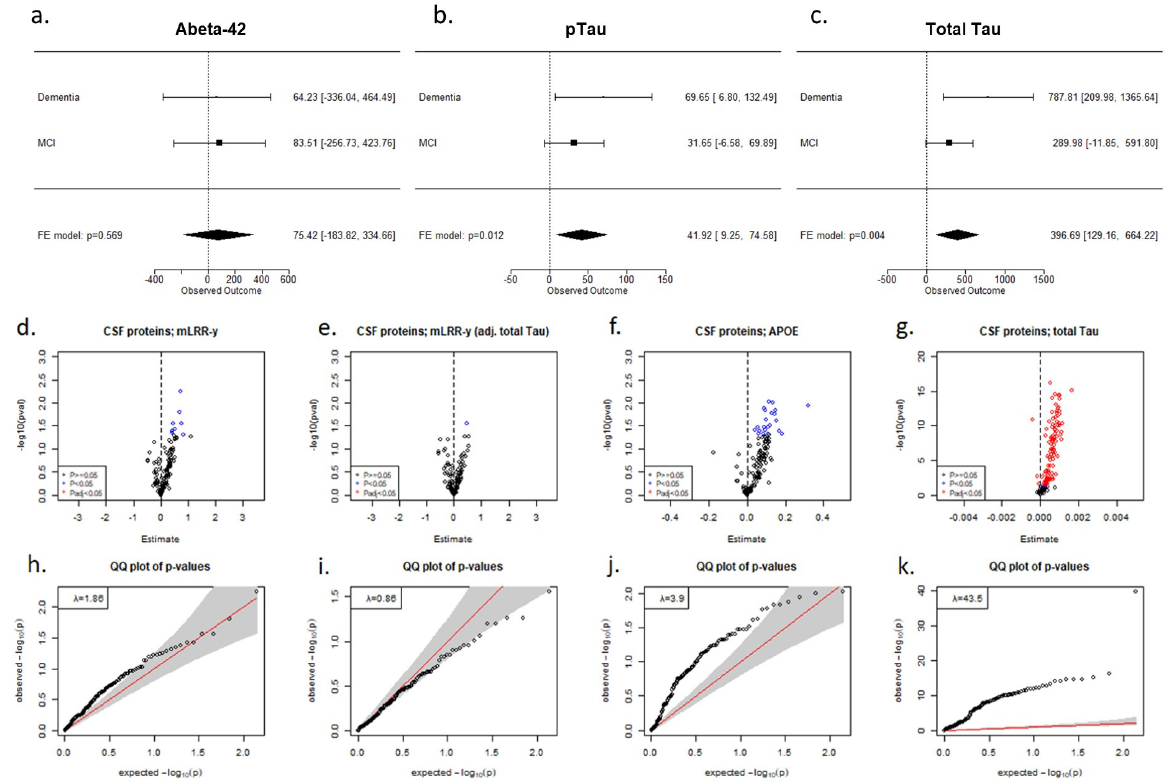
Figure 3. mLRR-Y associations with CSF protein levels. ( a – c ) Forest plots showing the effect size obtained in linear regression models for mLRR-Y on ( a ) Abeta-42, ( b ) phospho-tau, and ( c ) total tau in men with MCI or dementia, along with the meta-analysis results. ( d – g ) Volcano plots showing association of CSF proteins in the Olink inflammation and neurology panels with ( d ) mLRR-Y, ( e ) mLRR-Y adjusted by total tau, ( f ) APOE genotype, and ( g ) total tau. ( h – k ) QQ plots obtained in the models for ( h ) mLRR-Y, ( i ) mLRR-Y adjusted by total tau, ( j ) APOE genotype, and ( k ) total tau. We adjusted the models by age, the time window between CSF and DNA sampling, and APOE geno- type.